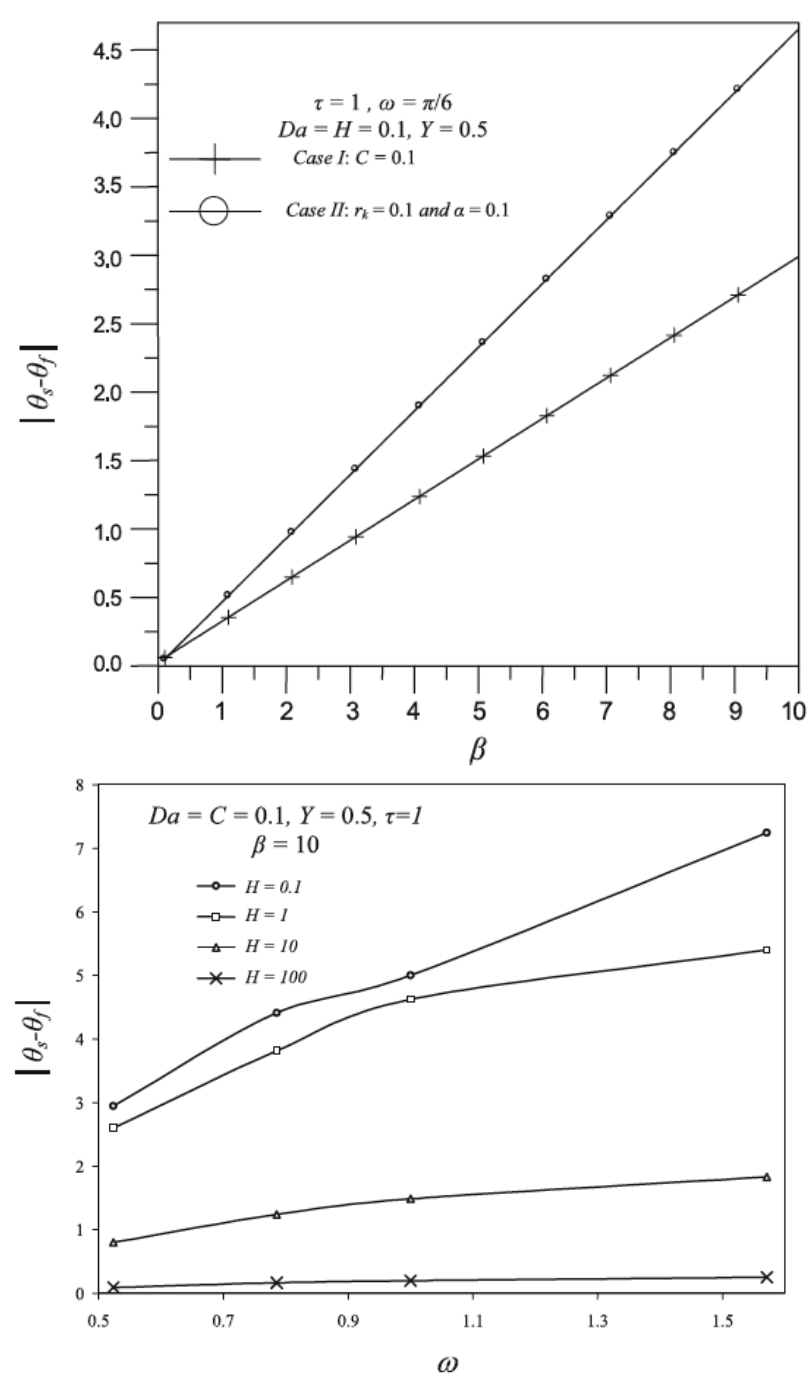
(cid:12) (cid:12) Figure 35. Absolute temperature difference ( (cid:12) θ s − θ f (cid:12) ) against ( Top ) amplitude ( β ) and ( Bottom ) frequency ( ω ), of the thermal disturbance, presented by Khadrawi et al. [57]. They reported that increasing Darcy number or Rayleigh number, which enhances the flow circulation intensity, enhances the LTNE , as shown in Figure 36. In contrast, it was revealed that higher values of modified Biot number or the fluid/solid thermal conductivity ratio depreciate the LTNE and improve the LTE condition, as shown in Figure